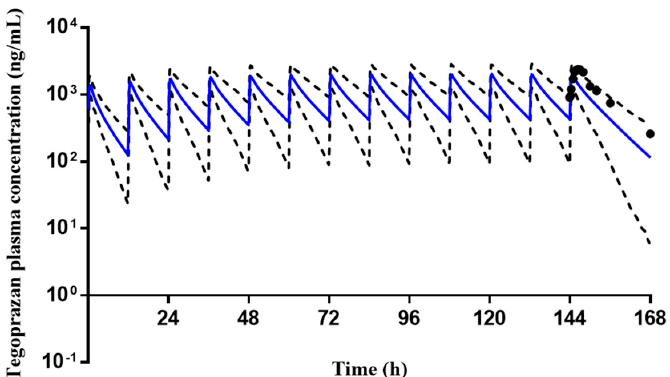
Figure 4. The mean observed (black dot, n = 20 [11]) and predicted plasma concentration–time profiles of tegoprazan 100 mg with amoxicillin 1000 mg and clarithromycin 500 mg twice daily for 7 days (solid blue line, n = 100). The gray dotted lines represent the 5th and 95th percentiles. The observed data were adapted from a reference